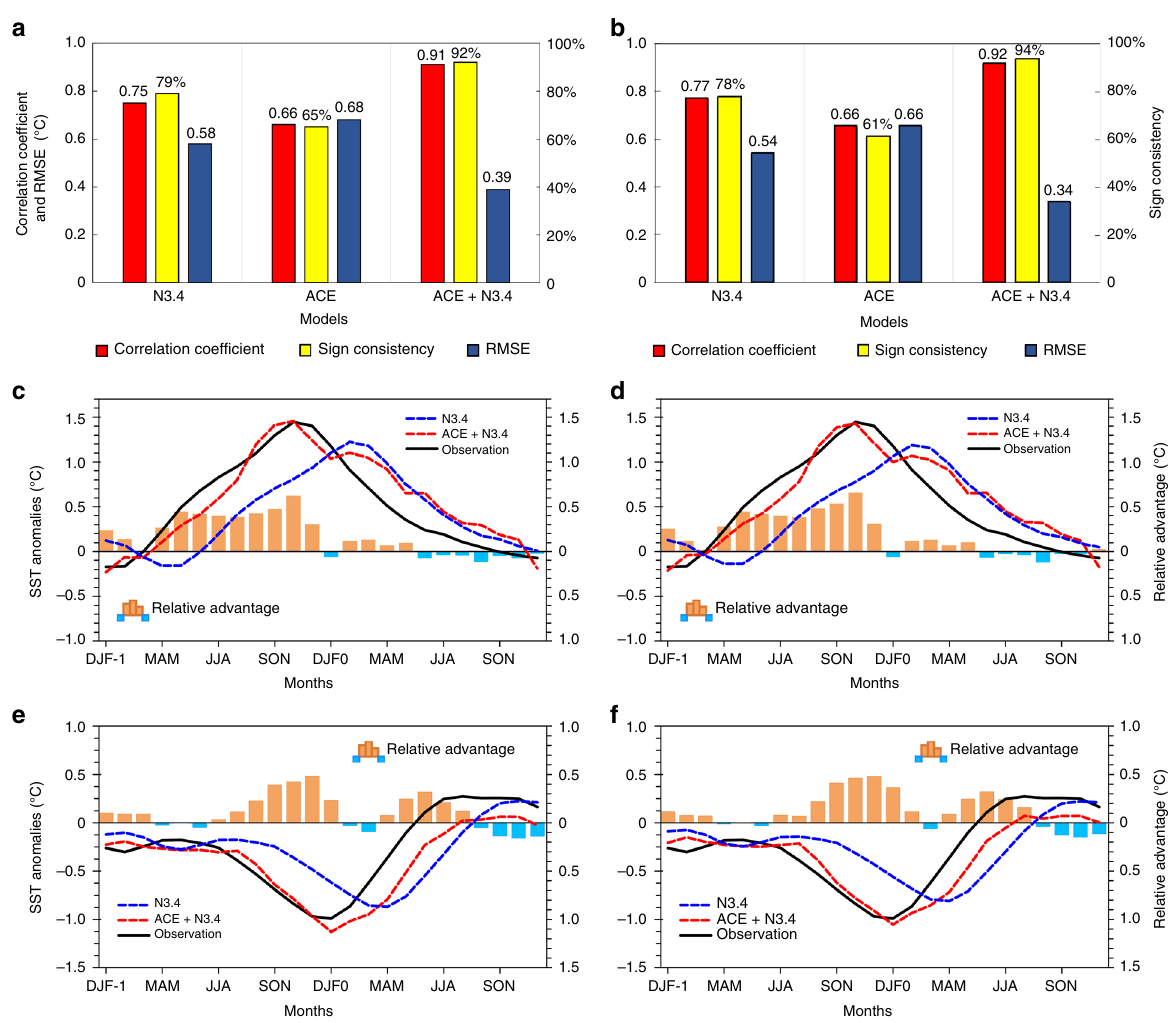
Fig. 7 Prediction skill of three statistical models for the running 3-month mean SST anomaly for the Niño 3.4 region (5°N − 5°S, 120° − 170°W) (N3.4, an ENSO index) in the hindcasting period 2000 – 2016. a Correlation coef fi cient (red bars), sign consistency (%, yellow bars) and root mean square error (RMSE, °C, dark blue bars) between N3.4 (°C) observations and predictions based on three statistical models (N3.4, ACE, and ACE + N3.4) using the holdout method. b Same as a , but for results using the running holdout method. c Composite time series of N3.4 for observations (black solid line) and predictions (dashed lines) during El Niño events (all events, including 2002 − 2003, 2004 − 2005, 2006 − 2007, 2009 − 2010, 2014 − 2015 and 2015 − 2016) with the holdout method. The blue (red) dashed line is for the N3.4 (ACE + N3.4) model. Bars indicate the amplitude of the models ’ relative advantage ¼ j ModelA (cid:3) Observation j (cid:3) j ModelB (cid:3) Observation j ) between the N3.4 and ACE + N3.4 models. Blue (orange) bars ( relativeadvantage modelA ! modelB represent the advantage of the N3.4 model relative to the ACE + N3.4 model (the ACE + N3.4 model relative to the N3.4 model). DJF-1 and DJF0 represent the December − February in last year and the year concurring with El Niño, respectively. d Same as c , but for results using the running holdout method. e Same as c but for La Niña (all events, including 2000 − 2001, 2005 − 2006, 2007 − 2008, 2008 − 2009, 2010 − 2011 and 2011 − 2012). f Same